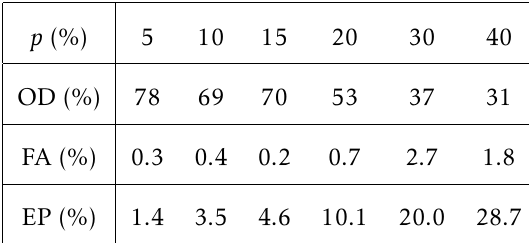
Table 3. The Combination Method Simulation Result ( p Indicates Prior Error Probability, OD denotes Outlier Detection, FA denotes False Alarm and EP denotes Error Probability.)